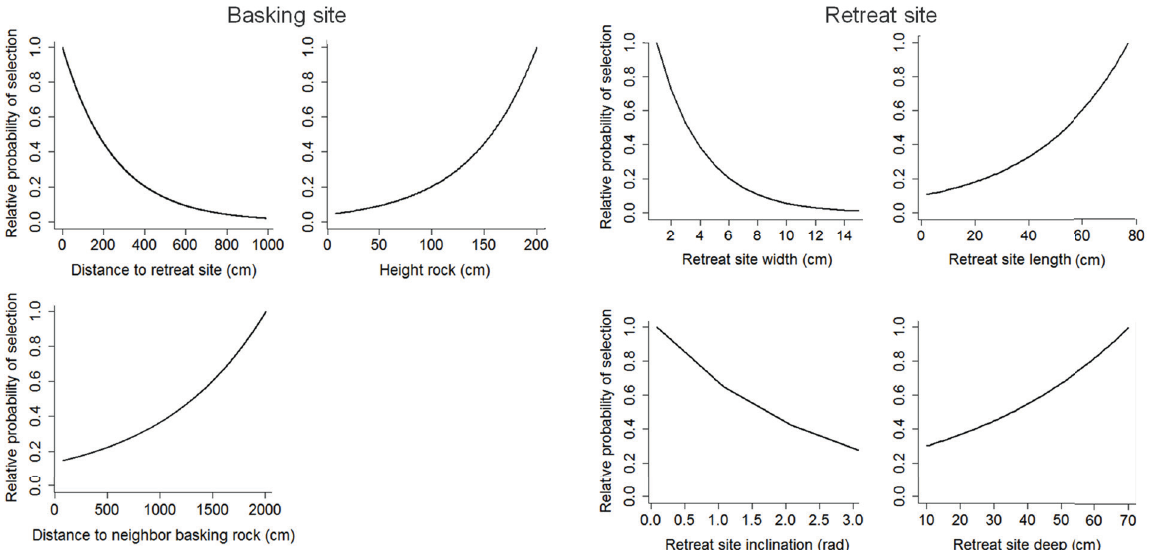
Figure 4. Plots showing the relative probability of basking site selection and retreat site selection of Phymaturus palluma assuming all other variables were held constant at their respective median, for the most important variables in the RSF models with a Δ AICc ≤ 2.